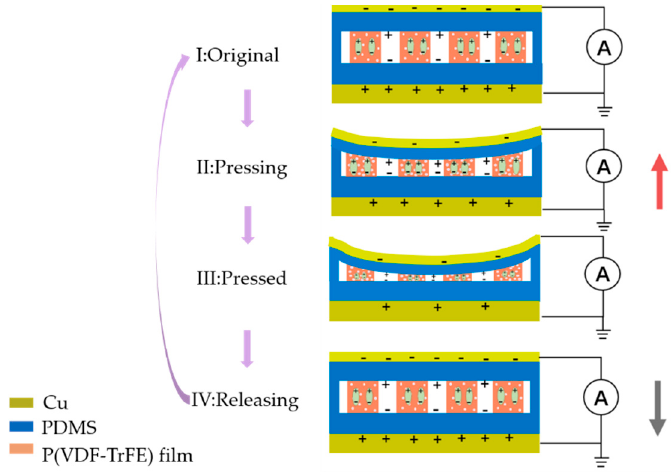
Figure 4. Schematic of the working principle of the flexible sensor.